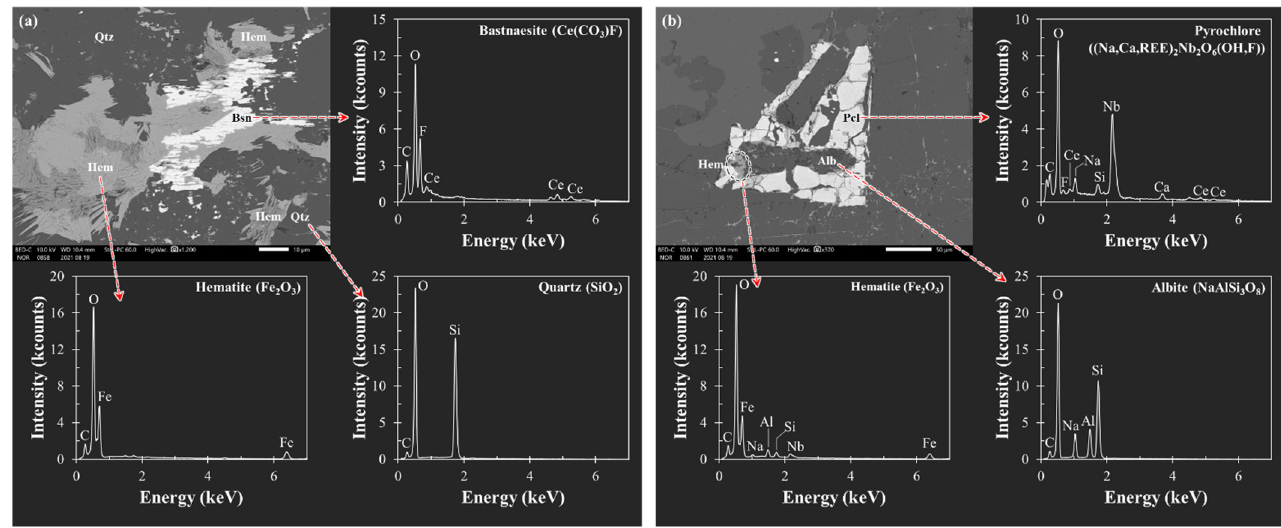
Figure 4. XRD pattern of the REE-bearing sample from the Khalzan Buregtei deposit, Mongolia.